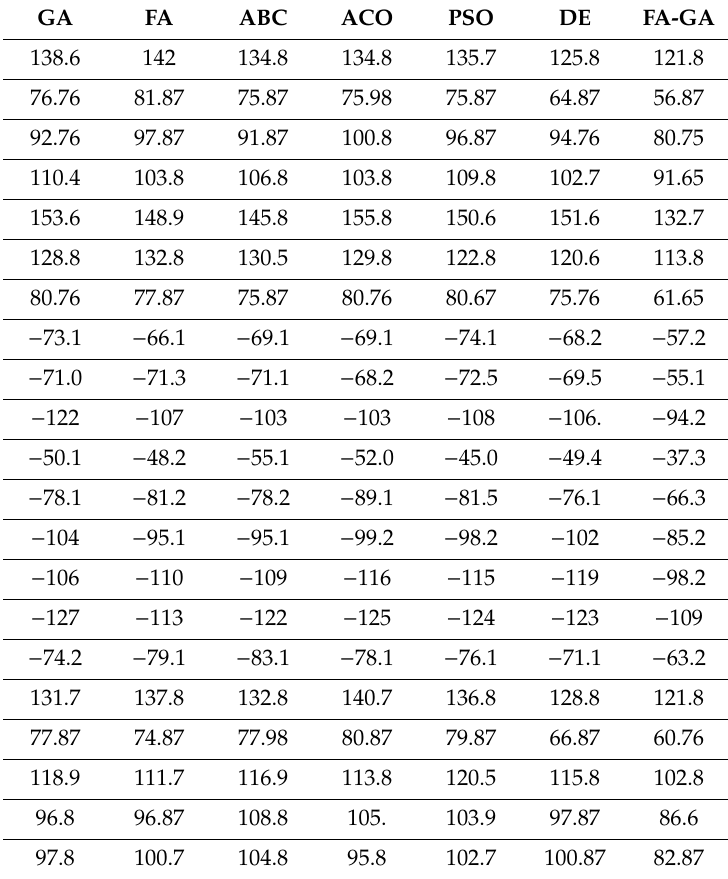
Table 6. Air quality error di ff erences based on the considered approaches.